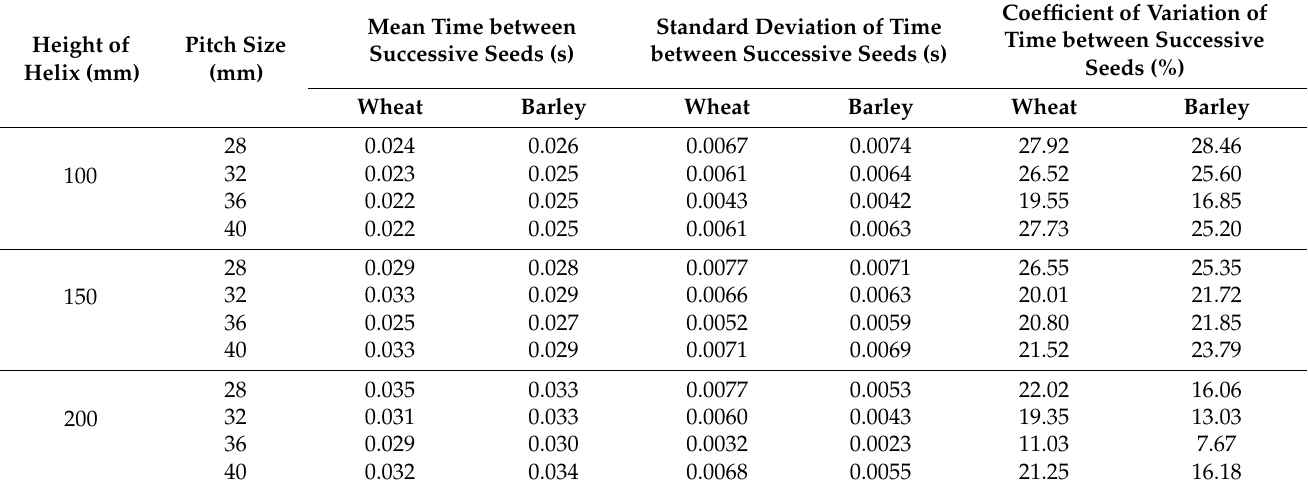
Table 4. The mean time, standard deviation, and coefficient of variation between successive seeds in the helicoidal seed tube measured in laboratory tests.